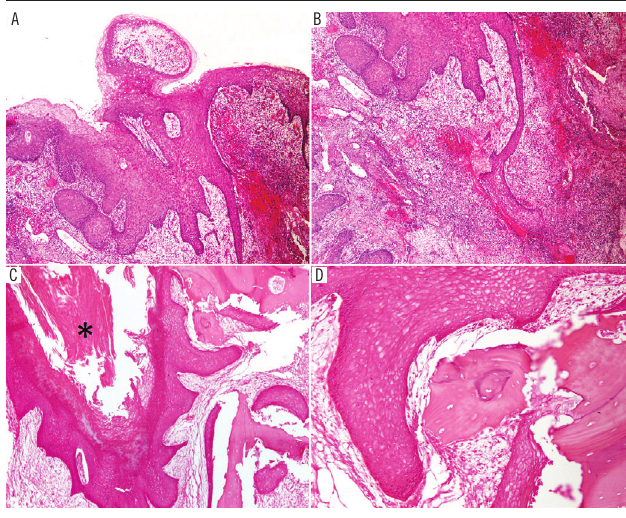
figurE 2 − The microscopic analysis showed intense well-differentiated squamous epithelial proliferation, with frequent invaginations (A, 5×). The fibrovascular stroma showed numerous inflammatory cells (B, 5×). Notice the large area of keratin deposition (asterisk), foci of osseous resorption in close relationship with florid squamous epithelial proliferation with prominent invagination (C, 5× and D, 20×). Hematoxylin and eosin